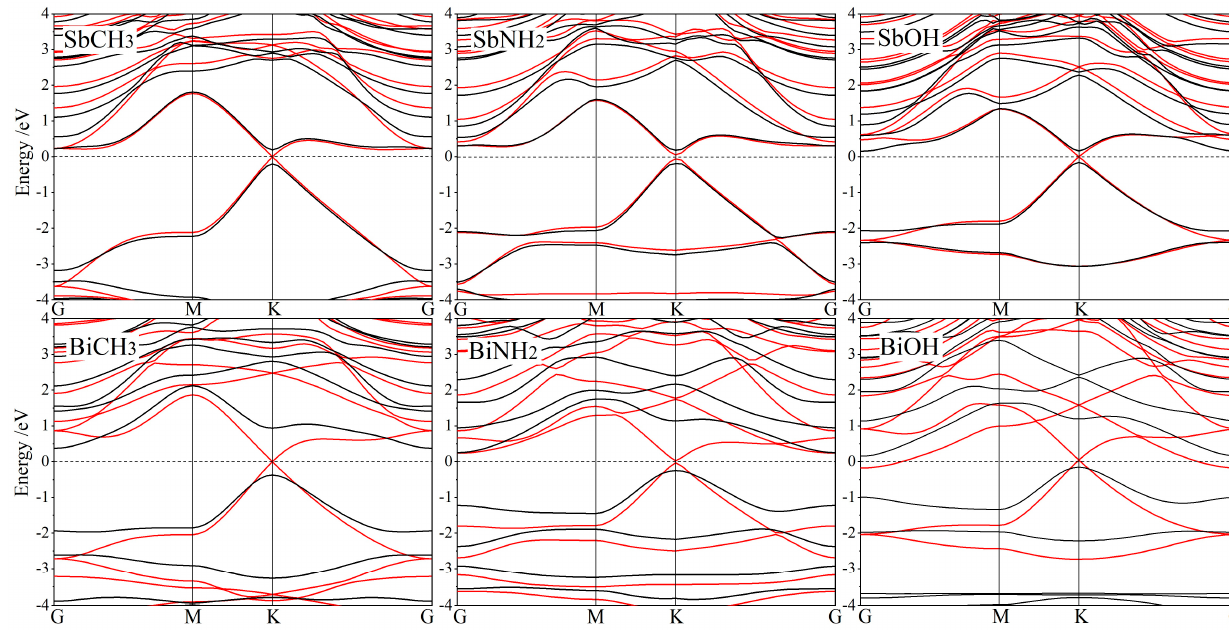
Figure 3. Band structures of SbXH n and BiXH n with SOC (black curves) and without SOC (red curves), in reference to Fermi level (horizontal dash lines).